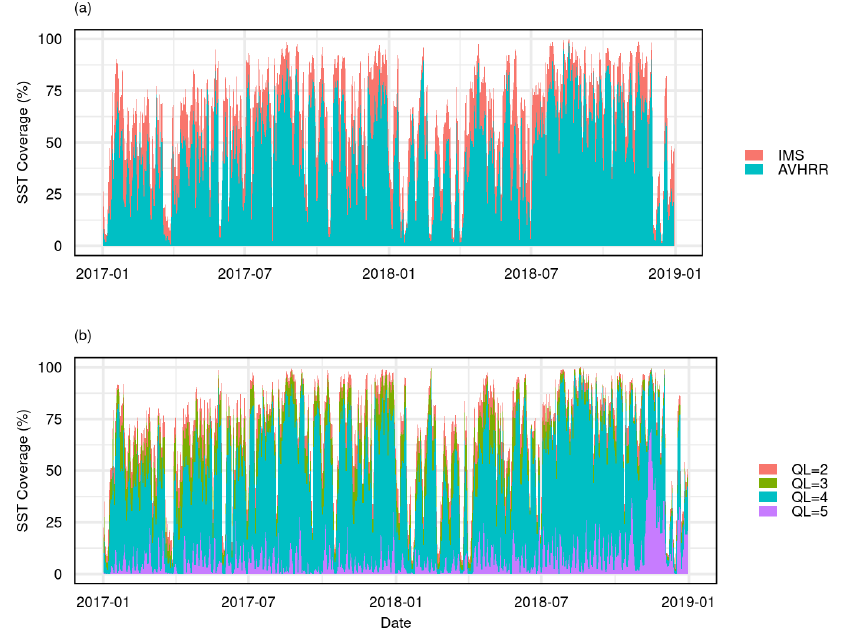
Figure 9. GBR Marine Park SST stacked plot of coverage (%) for ( a ) NOAA AVHRR versus Multi- sensor for QL ≥ 3 and ( b ) Multi-sensor by quality. Data were sourced from